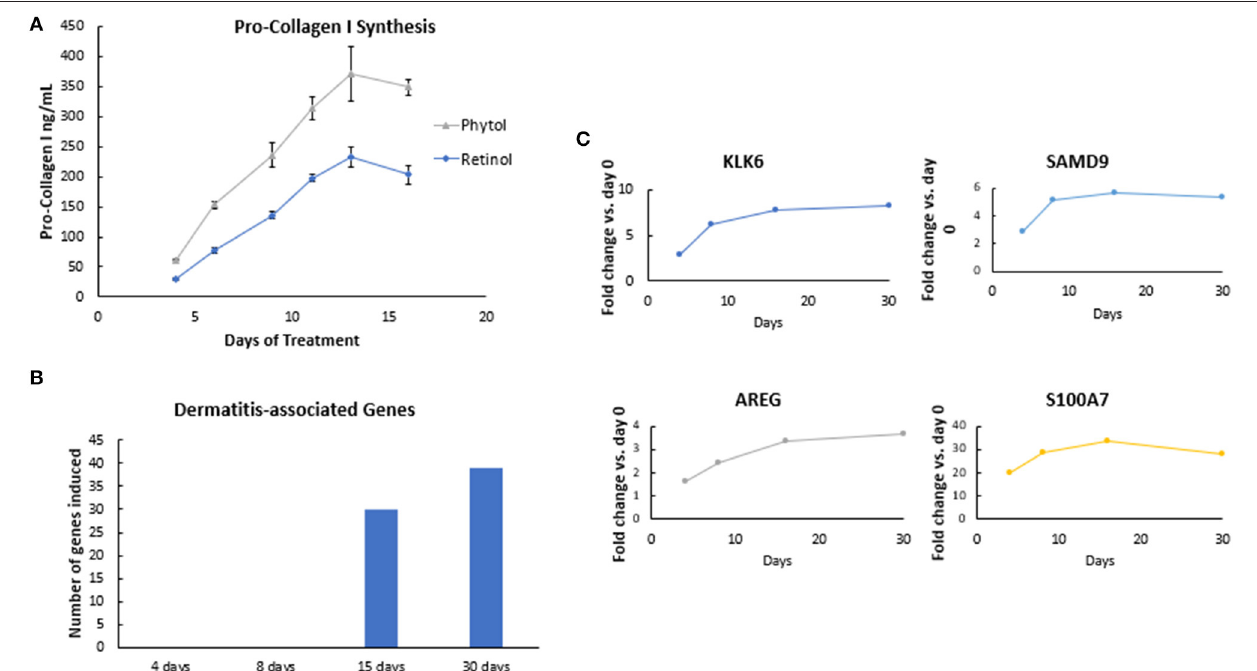
FIGURE 5 | Efficacy rate evaluation. (A) The effect of retinol and phytol on pro-collagen I synthesis in human dermal fibroblast cells. Human dermal fibroblasts were treated with 0.0001% phytol or 0.00003% retinol for a period of 16 days, and production of pro-collagen I was measured. The assay was performed in triplicate for each sample, and the values represent mean ± SD. Stimulation of pro-collagen I synthesis was observed with both active ingredients ( p < 0.05), but the rate of improvements decreased over time. (B) The effect of retinoic acid on gene expression in human skin. A formulation containing 0.02% retinoic acid was applied under occlusion on the lower dorsal arm. Subjects were treated daily for the first 5 days followed by treatment on alternate days for a total of 30 days. Skin samples were collected by punch biopsy on days 4, 8, 15, and 30. RNA was extracted, and whole genome expression was analyzed by Human U133 Plus 2.0 arrays. Retinoic acid treatment resulted in upregulation of Kallikrein-6 (KLK6), Sterile alpha motif domain-containing protein 9 (SAMD9), Amphiregulin (AREG), and Psoriasin (S100A) genes, which peaked on days 4–8, p < 0.05. (C) The effect of retinol on dermatitis-associated genes in human skin. A formulation containing 0.1% retinol was applied under occlusion on the lower dorsal arm. Subjects were treated daily for the first 5 days followed by treatment on alternate days for a total of 30 days. Skin samples were collected by punch biopsy on days 4, 8, 15, and 30. RNA was extracted, and whole genome expression was analyzed by Human U133 Plus 2.0 arrays. Pathway analysis performed using Ingenuity Pathway Analyses (IPA) showed that there was an increase in the number of dermatitis-associated genes after continued retinol treatment detectable at day 15.